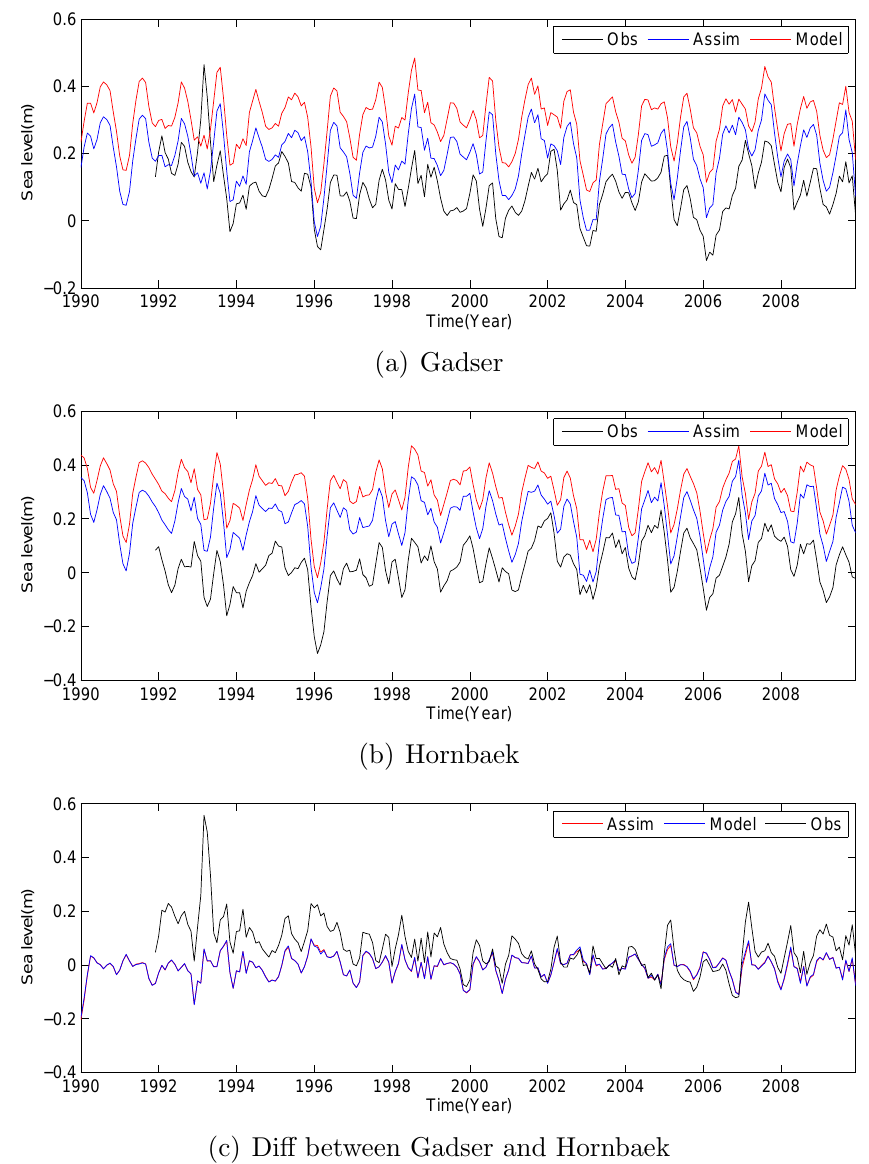
Fig. 10. The time series of sea level at Gedser (55.15 ◦ N, 15.92 ◦ E), Hornbæk (55.15 ◦ N, 15.92 ◦ E), and (c) the difference between (a) and (b) . The red is the free run, the blue is the reanalysis and the black is for observations. the mean RMSE is 1.46 psu for the Baltic Sea in the free run (Fig. 9b), while it is reduced to 1.15 psu in the reanalysis. Below 60 m, the RMSE is largely reduced from 1.74 psu